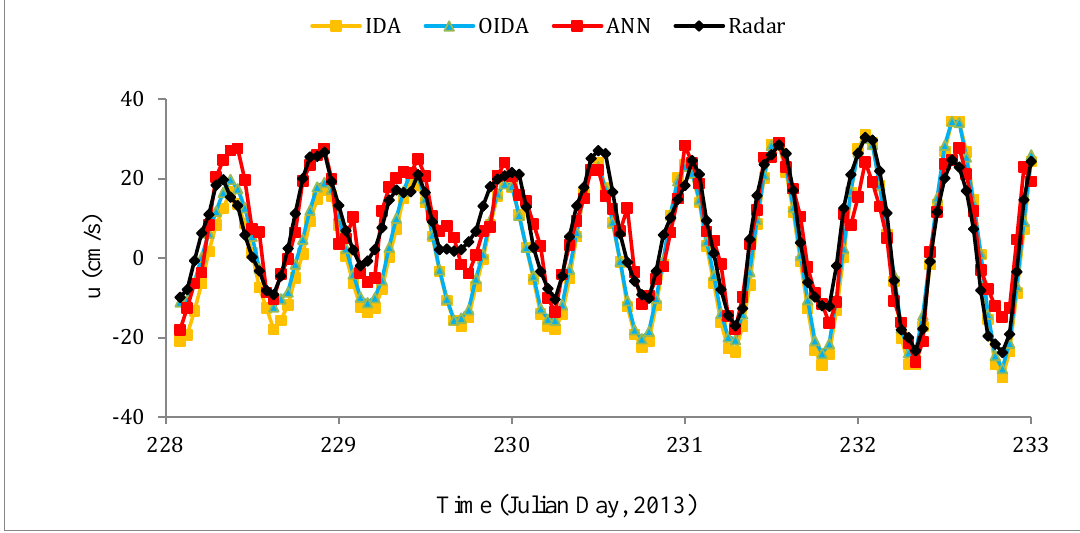
Figure 12. Forecasting of east–west velocity component at A3. IDA and OIDA indicate data assimilation using Optimal Interpolation and indirect correction method, respectively, the same convention of IDA and OIDA was used as follows. ANN indicates Model U17.